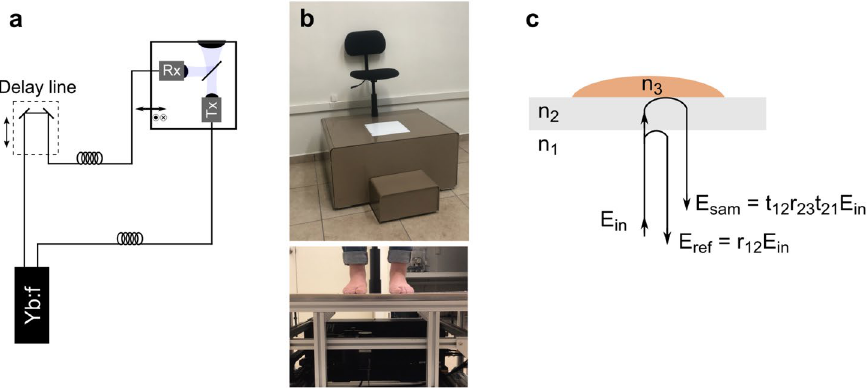
Figure 8. ( a ) Schematic representation of the fiber-coupled THz-TDS system used. ( b ) Photographs of the MMAT platform built for the acquisition of the THz images of the feet of patients. ( c ) Ray schematic of the terahertz radiation